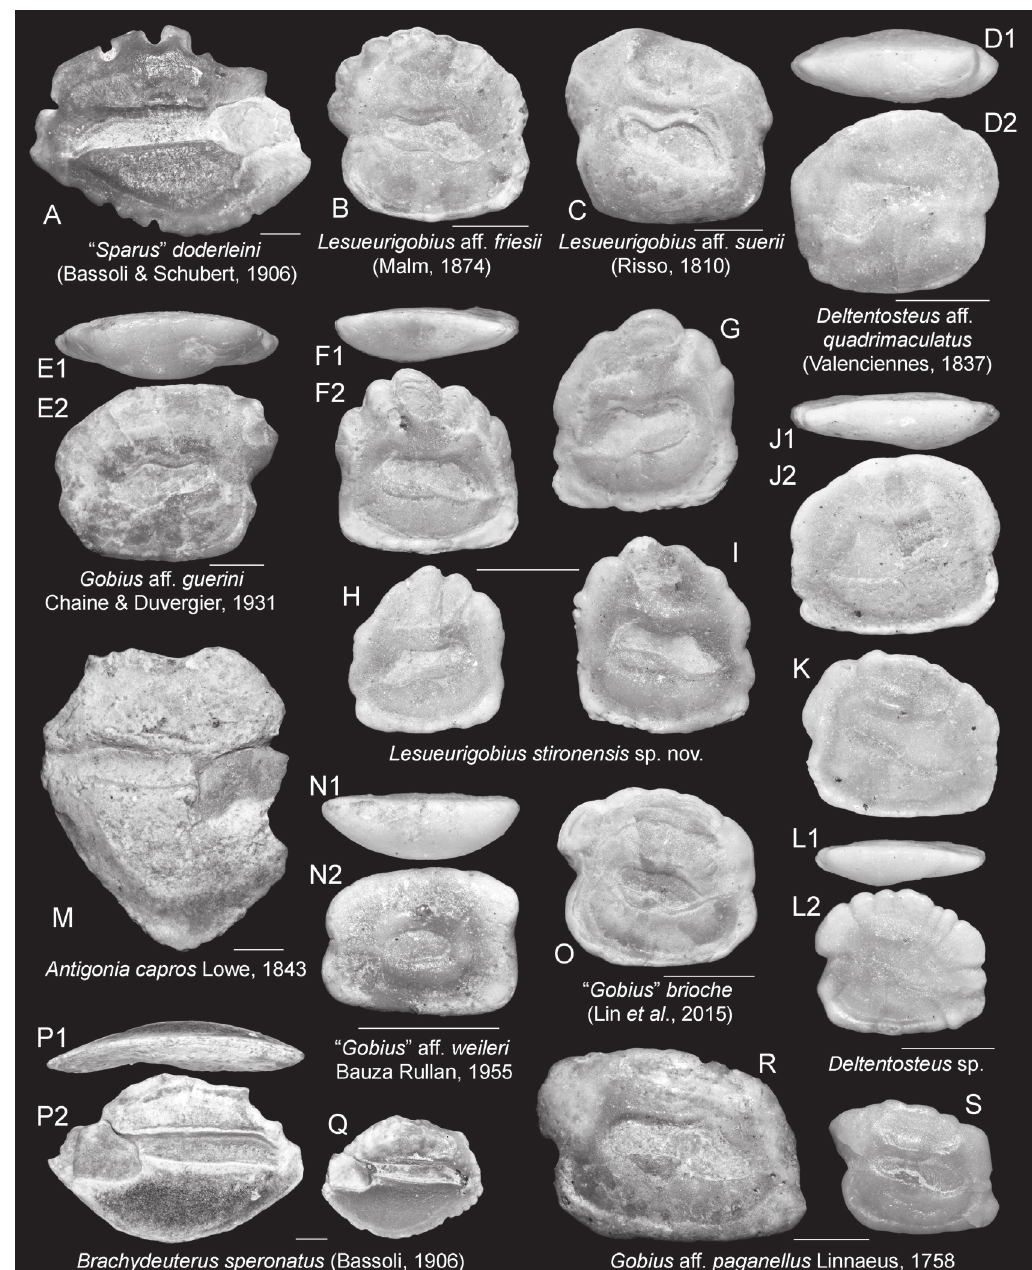
Fig. 11. Tortonian fish otoliths from northern Italy. A . “ Sparus ” doderleini (Bassoli & Schubert,